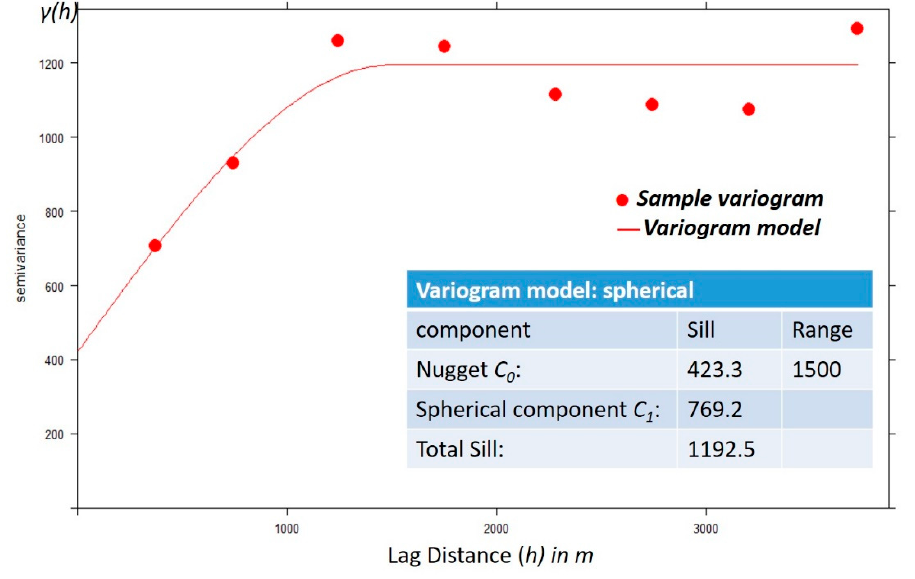
Figure 3. Experimental semivariogram with the spherical model fitted at Amyntaio mine area.